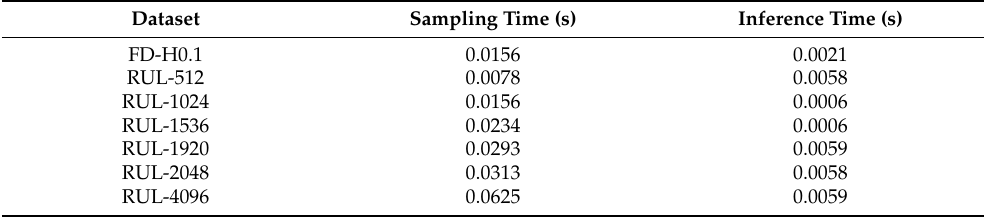
Table 7. Sampling time and model inference time for different tasks and different sample lengths of data.